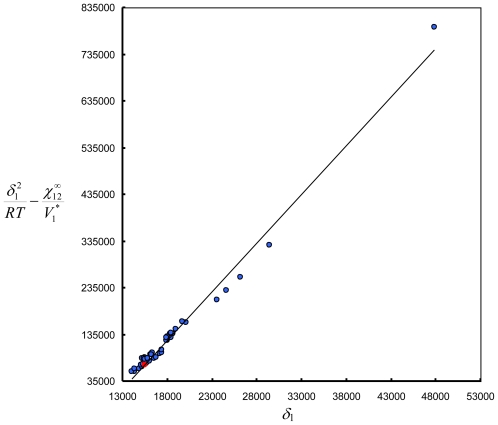
An example of the determination of solubility parameter δ2. Plot of
δ12RT-χ12∞V1* versus δ1 according to the Equation 7 for ionic liquid [emim][TCB] at T = 298.15 K. (
) n-octane, (
) rest of solutes.